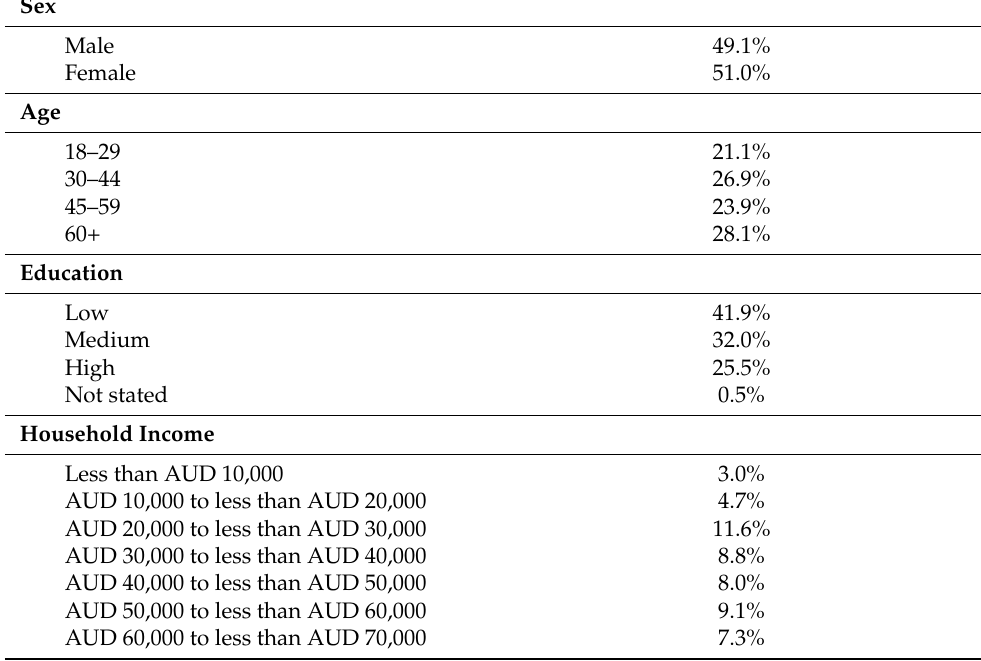
Table 2. Sociodemographic characteristics of Australian IFPS respondents, 2020 ( n =